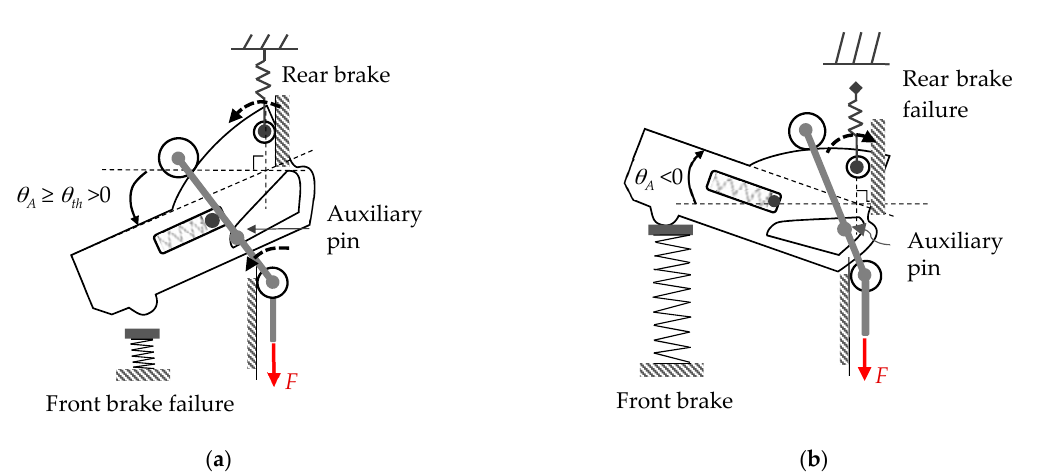
Figure 11. Schematic of failure mode operations. ( a ) swingarm and link C locked together when front brake failure occurs for θ A ≥ θ th > 0; ( b ) swingarm rotates freely with rear brake failure θ A < 0.